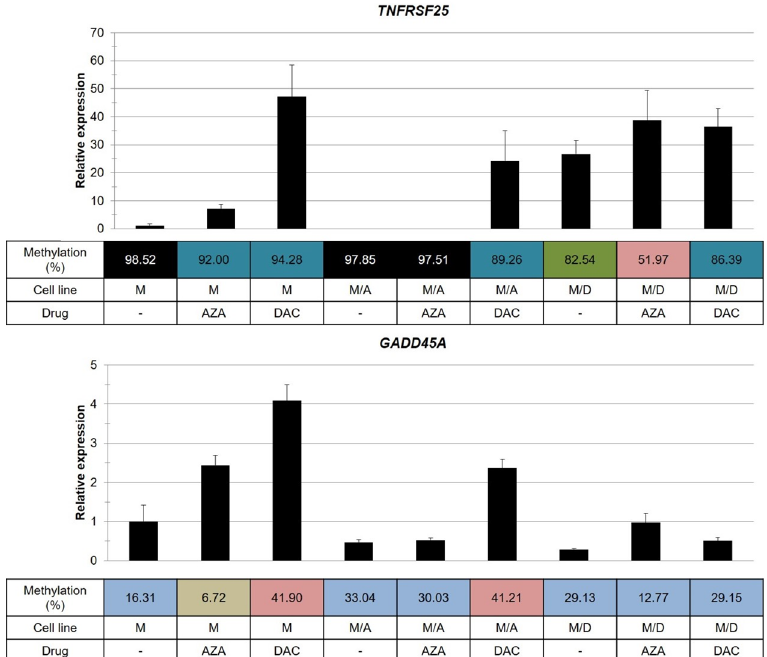
Figure 6. Changes in the relative expression and methylation of GADD45A and TNFRSF25 in sensitive and resistant cell lines. M—MOLM-13-sensitive cell line; M/A—MOLM-13/AZA, AZA-resistant subline; M/D—MOLM-13/DAC, DAC-resistant subline. The cells were incubated for 72 h in growth medium in the absence or presence of AZA (1 µ M) or DAC (1 µ M) in a CO 2 incubator. The cells were treated every 24 h with either AZA or DAC. ACTB was used as an internal control. The data are expressed as the mean ± SD of three independent